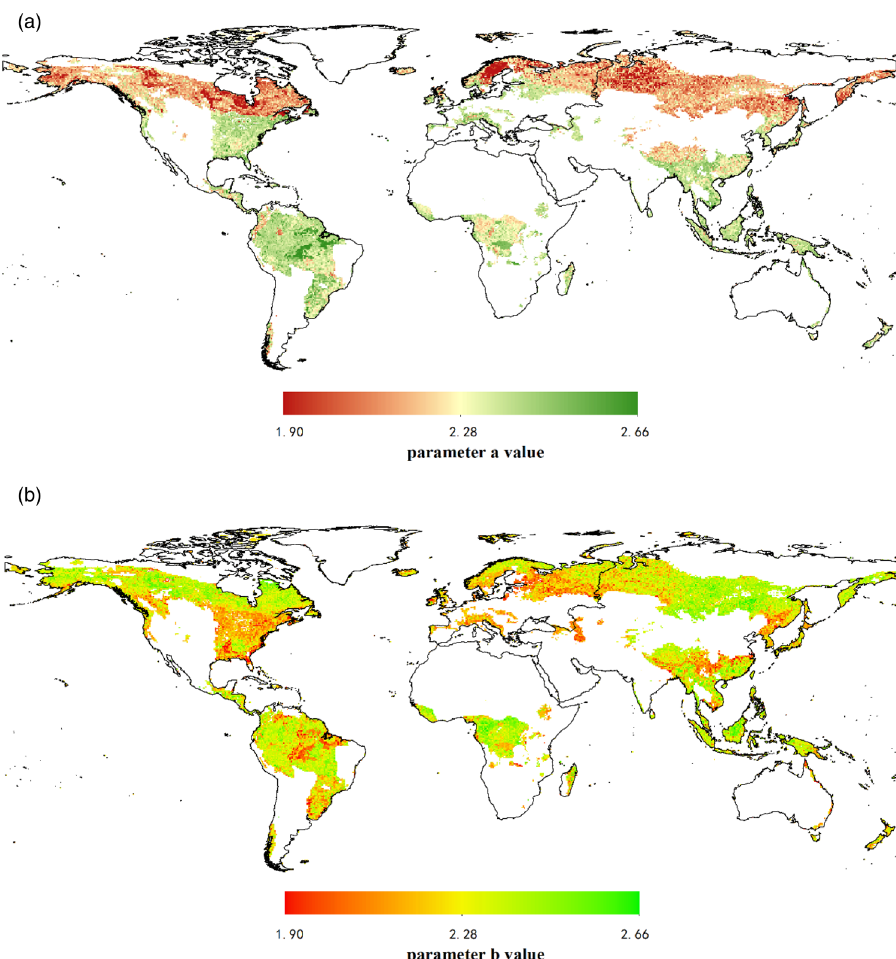
Figure 4. Global pattern of allometric model (LnW = a + b*Ln(D)) parameters prediction map. ( a ) Parameter a value. ( b ) Parameter b value. The maps are created in R 4.0.3 (URL https:// www.R- proje ct. org/) and QGIS 3.16.0 (URL https:// qgis.